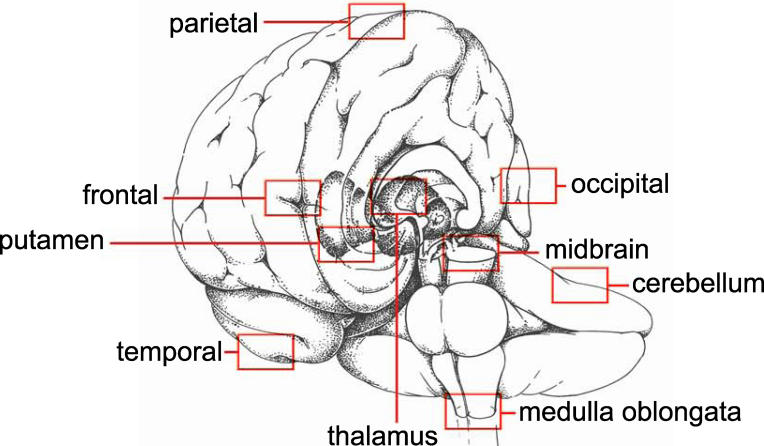
PrP
Sc profiling was done in nine different central nervous system areas